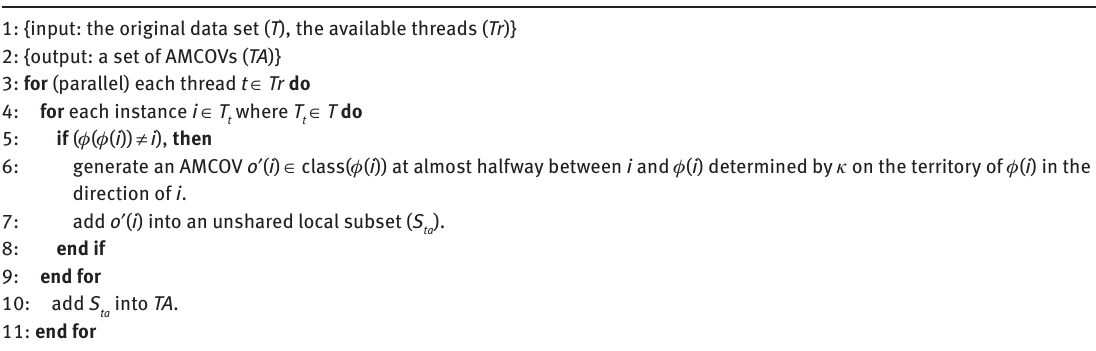
Algorithm 2: Parallel AMCOV generation